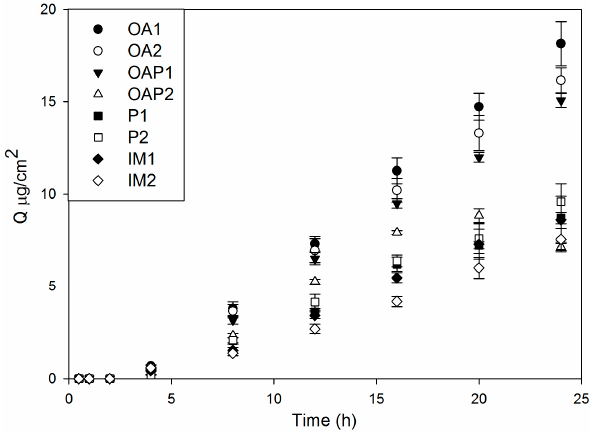
Figure 8. Release profile of DXM-loaded liquid crystal formulations (0.1% w / w ) described in Table 1.